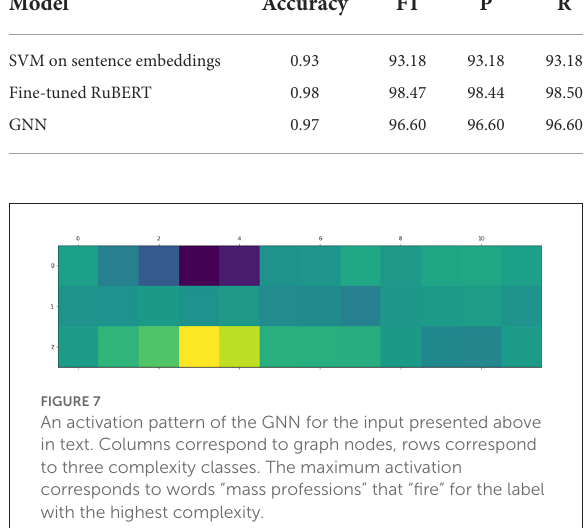
FIGURE7 An activation pattern of the GNN for the input presented above in text. Columns correspond to graph nodes, rows correspond to three complexity classes. The maximum activation corresponds to words “mass professions” that “fire” for the label with the highest